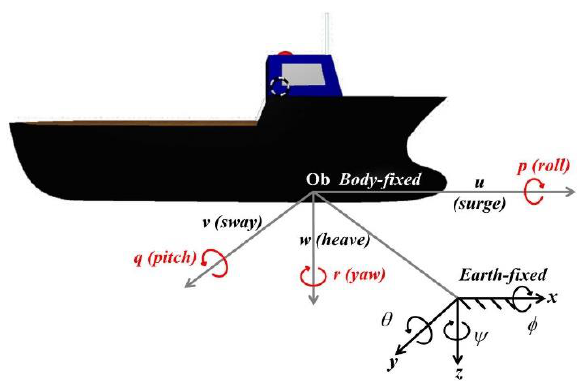
Figure 1. Body-frame and Earth frame definitions of controlled autonomous unmanned surface vessels (AUSV).